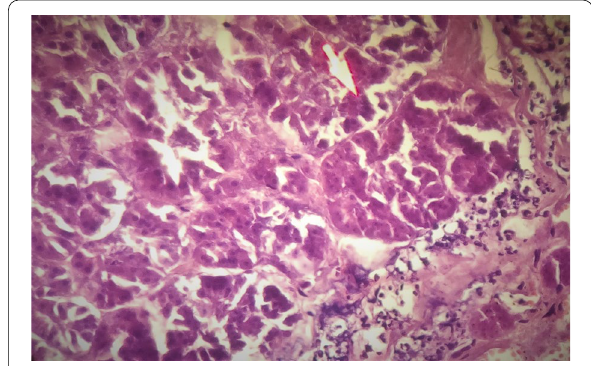
Fig. 3 Pancreatic acini (semi-autolyzed-high power-H&E)